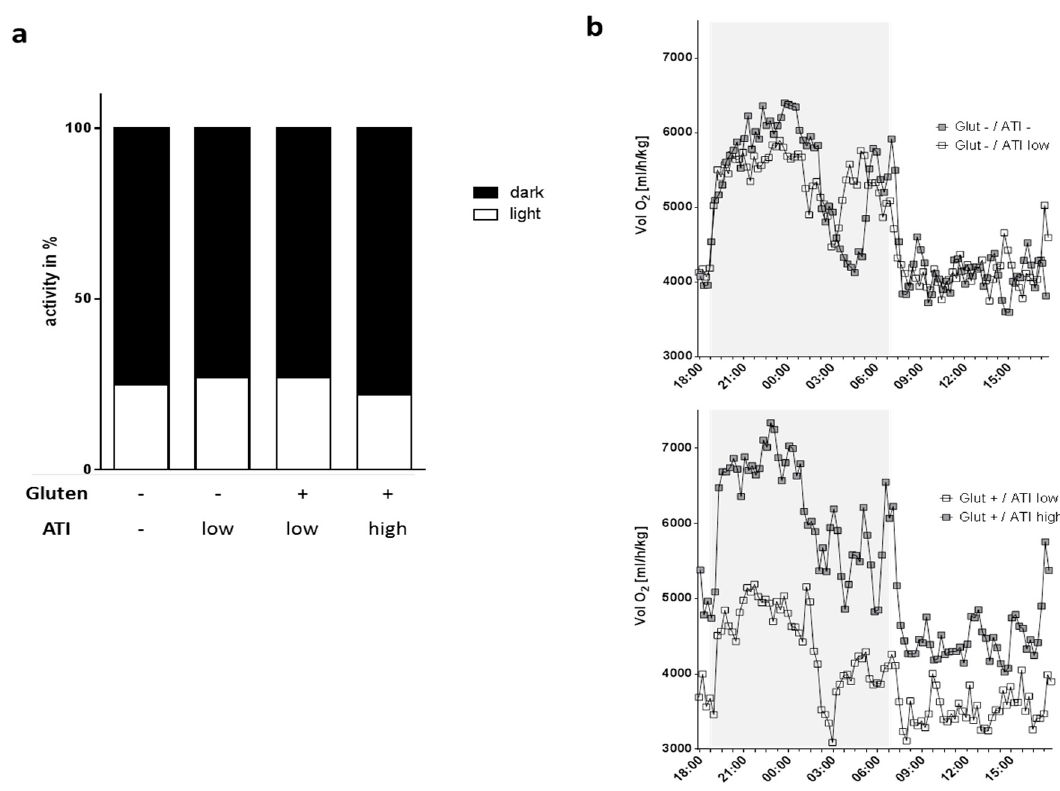
Figure 2. Activity and metabolic capacity of 5xFAD mice under the 4 different diets. ( a ) Locomotive activity during dark and light phase was assessed by light-beam sensors. ( b ) Oxygen consumption. Mice were placed in metabolic cages for 48 h and one cycle of measurement including 24 h was used for analysis ( n ≥ 7 per group). The dark phase is indicated by a grey box. Shown are means per time point; SEMs and p -values of multiple t-test comparison are not shown for clearness of the graphs ( p -values are given in Table S2).